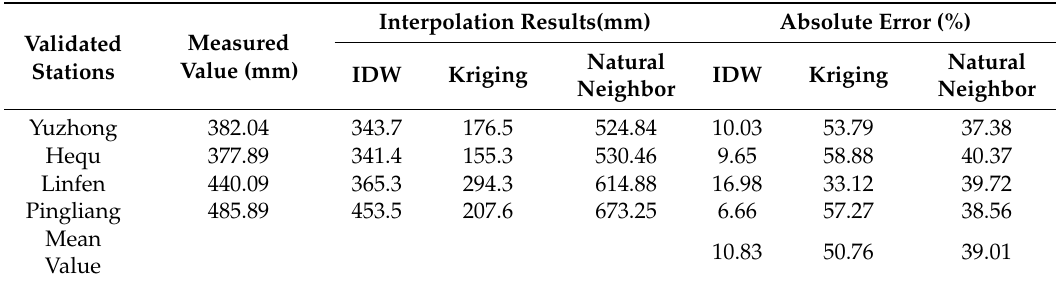
Table 1. Error comparison among three different spatial interpolation